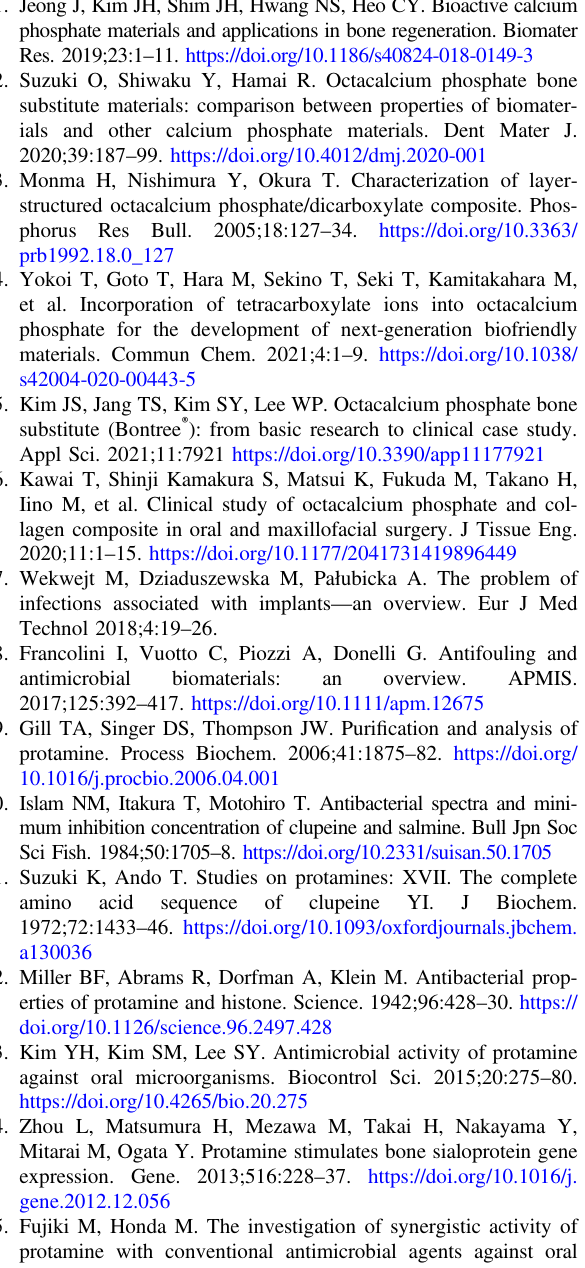
Fig. 9 Concentration of protamine released in the cultured super- natants after incubation of S. aureus for 6 h ( n =